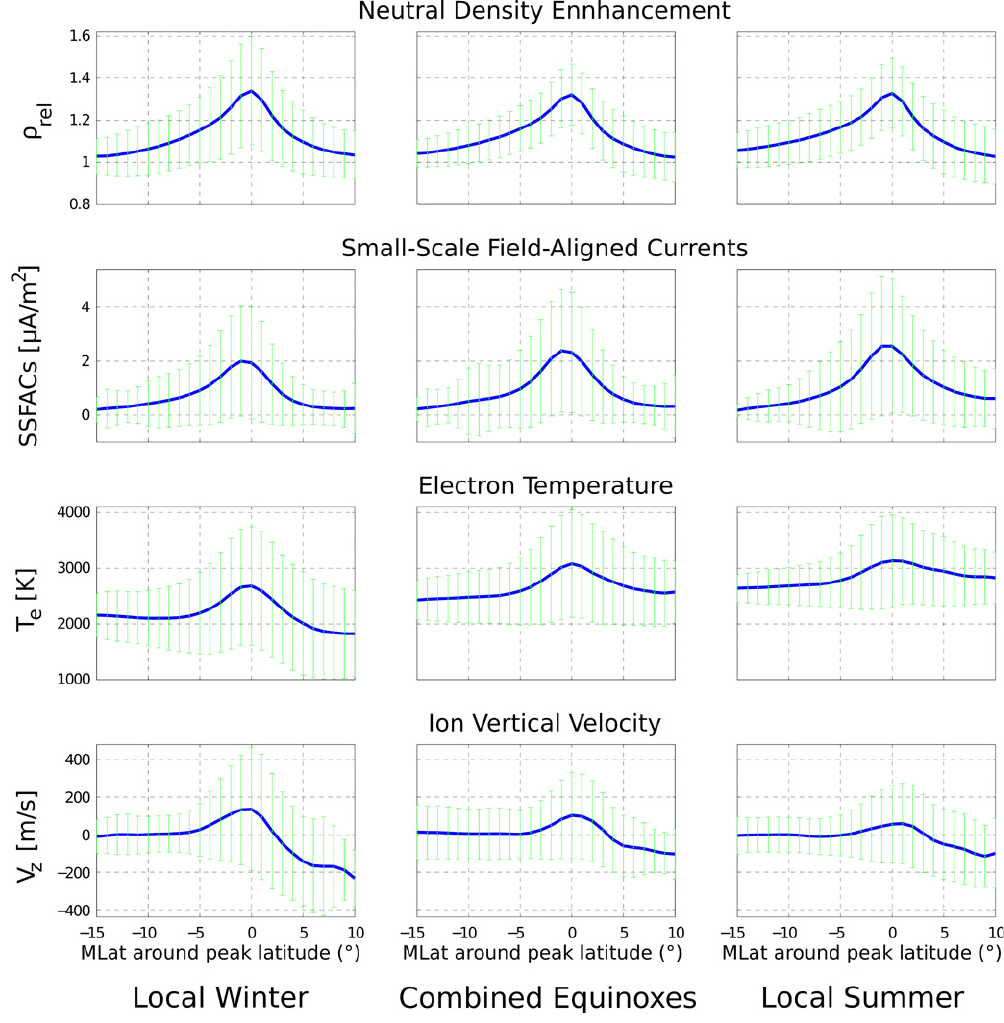
Fig. 6. The superposed epoch analysis results for latitude profiles of ρ rel , SSFACs, T e , and V z values from top to bottom, respectively, for the three local seasons: local winter (left column); combined equinoxes (middle column); local summer (right column). The error bars represent the standard deviations of 1 ◦ MLat averages. Used data covers 4yr (March 2002–March 2006) of CHAMP and 4yr (March 2002– December 2005) of DMSP observations in the Northern Hemisphere.